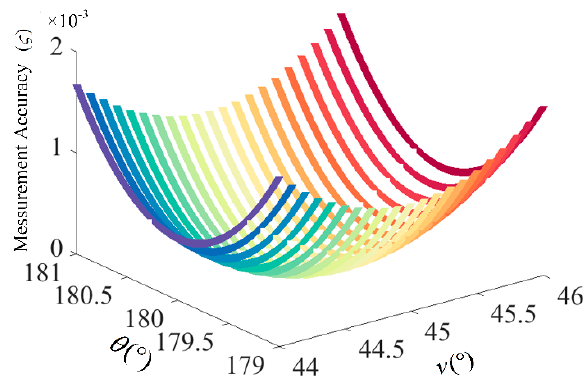
Figure 5. The influence of β and σ on the measurement accuracy of closed-loop OVSs.